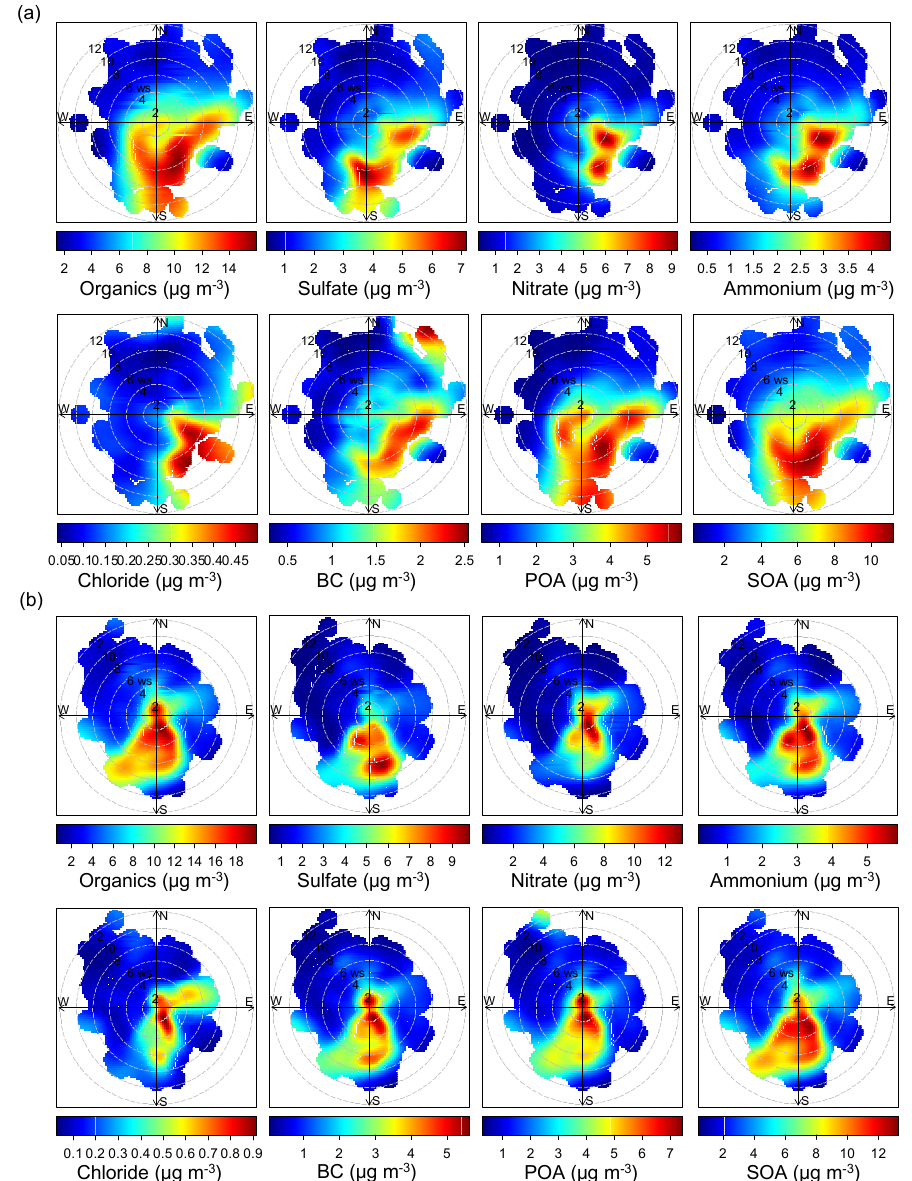
Figure 9. Bivariate polar plots of PM 1 species during the (a) control and (b) non-control periods at 260m as functions of wind direction and wind speed (ms − 1 )